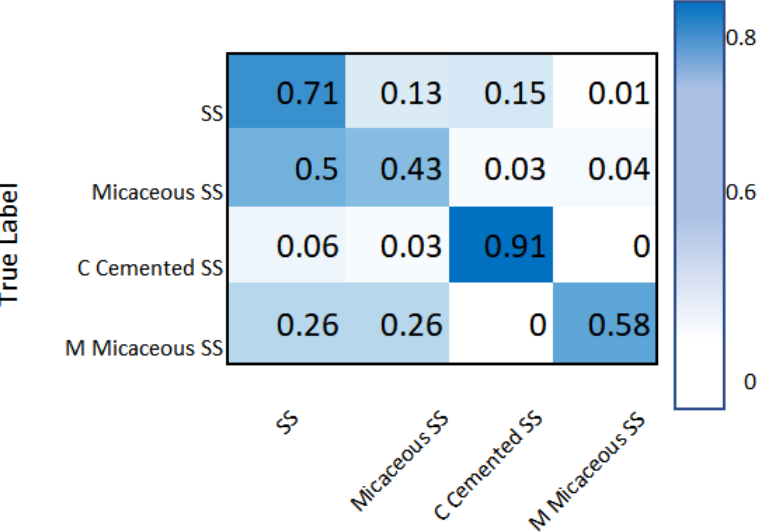
Figure 2. Confusion matrix for the test set, using a 1 m acceptance. Reprinted with permission from [2], copyright Society of Petroleum Engineers (SPE), 2021.